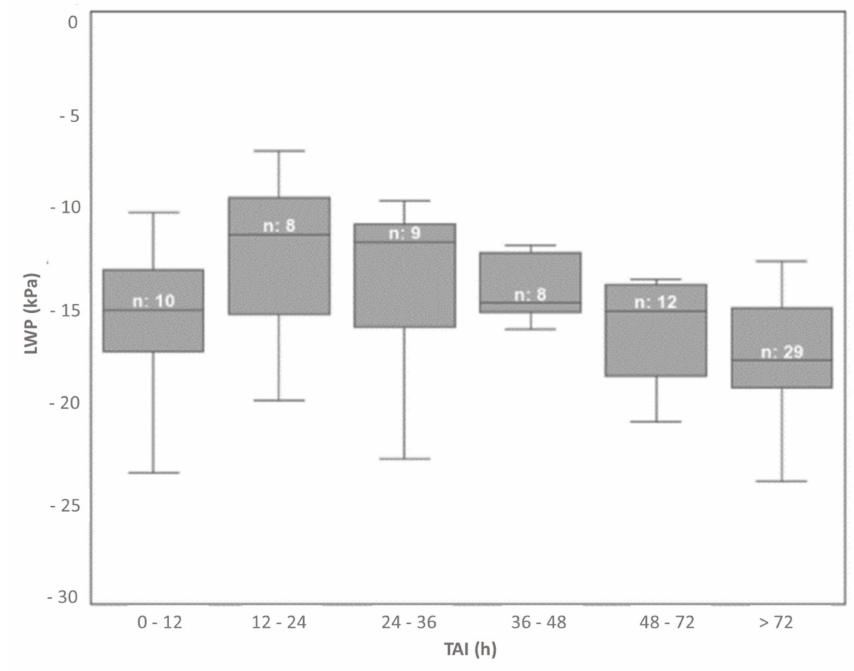
Figure 11. Temporal variability of the leaf water potential in different time lapses after irrigation (TAI).